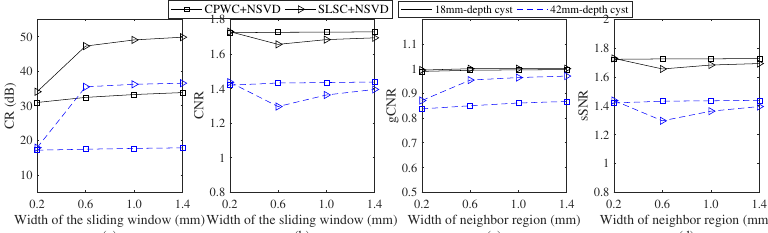
Figure 17. Effect of the width of the sliding window on ( a ) CR, ( b ) CNR, ( c ) gCNR, and ( d ) sSNR in simulated cyst target